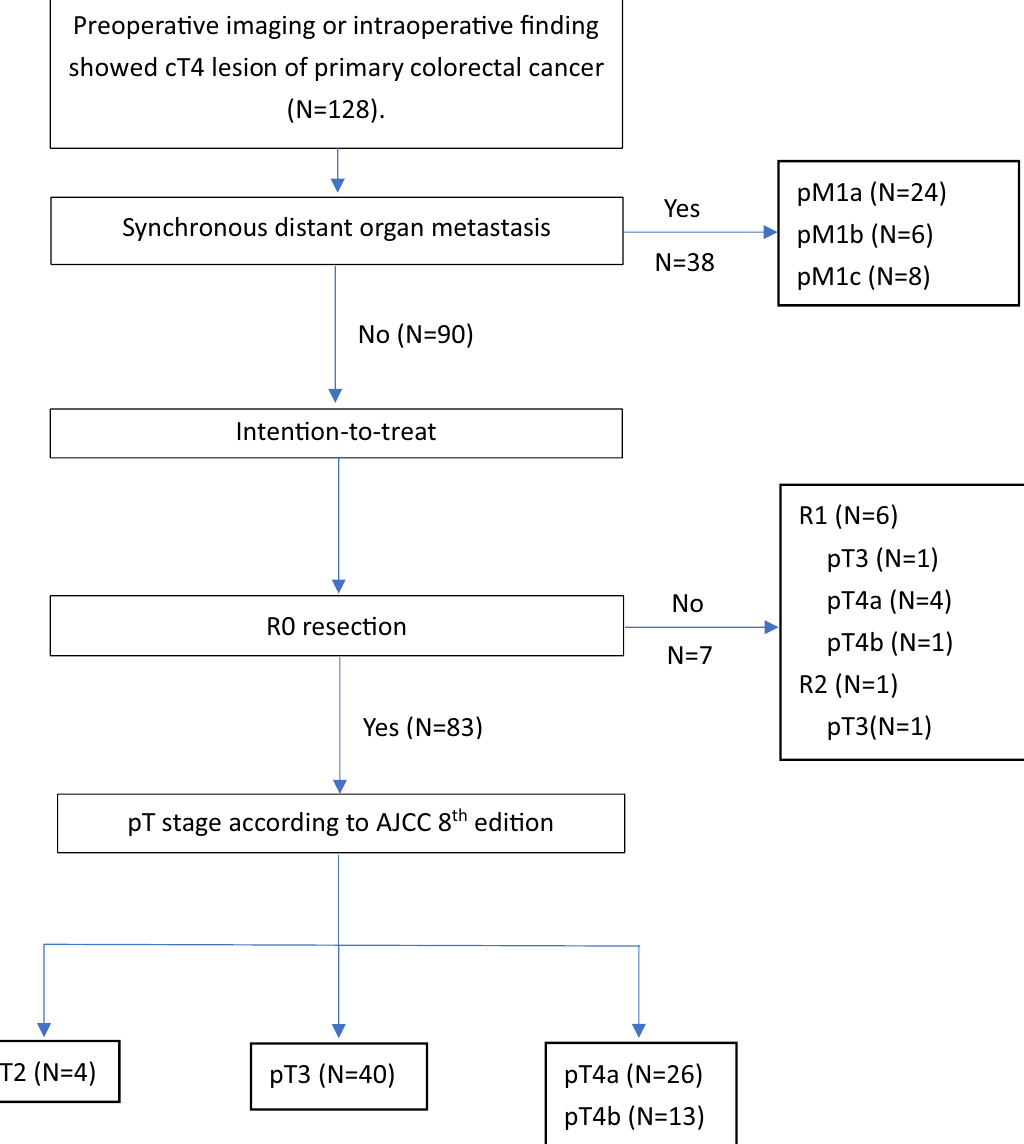
Figure 1. Patients’ recruitment and selection for clinically T4 lesion of colorectal